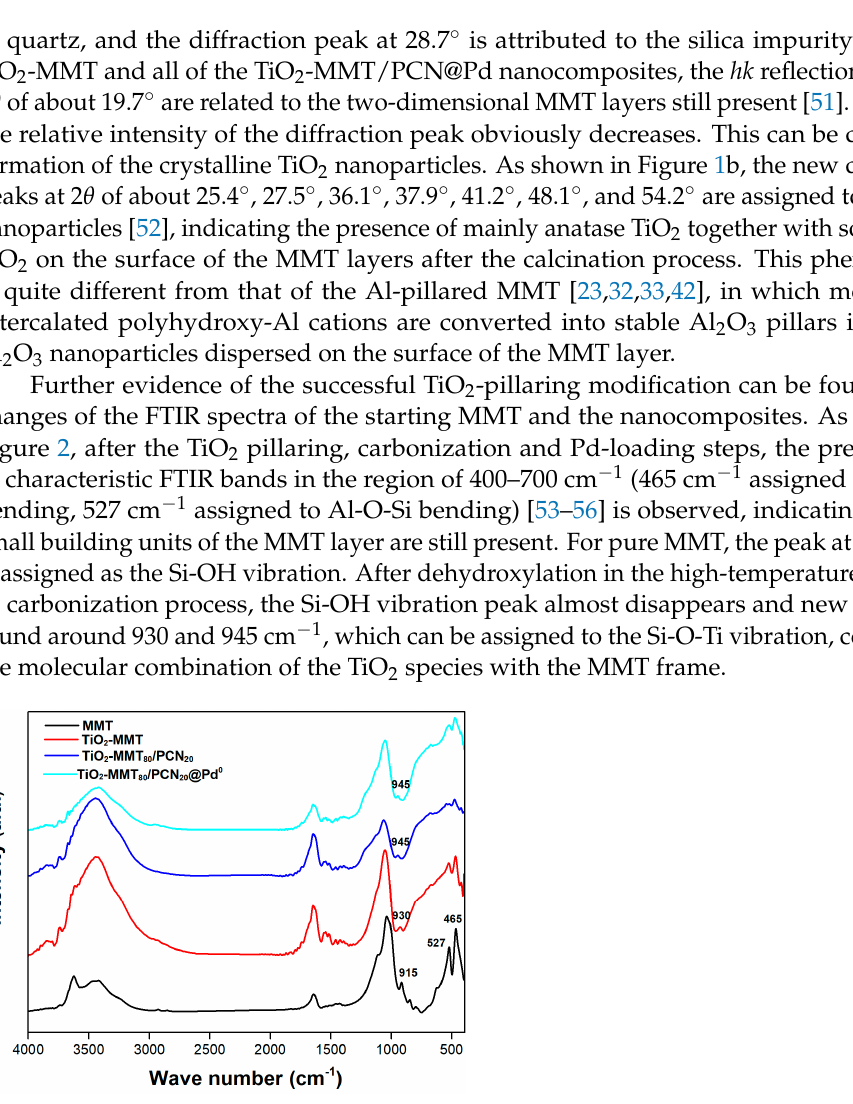
FTIR spectra of the MMT, TiO 2 -MMT, TiO 2 -MMT 80 /PCN 20 support, and TiO 2 - MMT 80 /PCN 20 @Pd 0 nanocomposites.